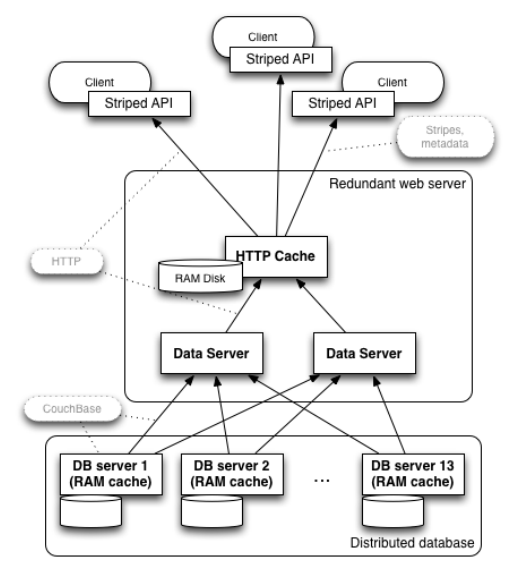
Figure 4. Demo instance of the striped